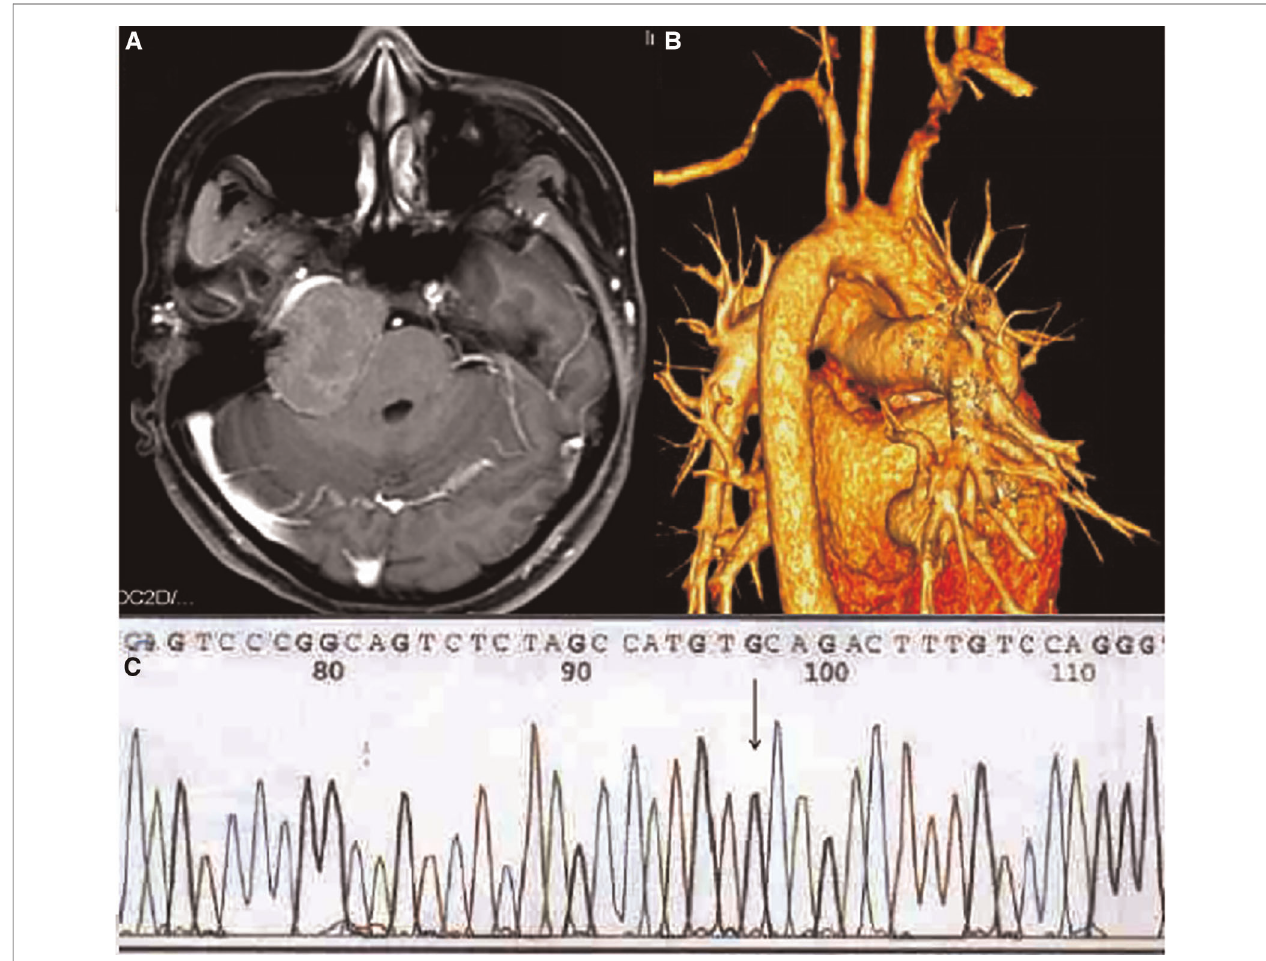
Figure 1 | ( A ) MRI showd the skull base has long T1 and long T2 lesions on the right side of the middle straddle, with fl air showing mixed signals; local bone destruction in the lesion. ( B ) Coronary CTA showed multiple mural thrombus with calci fi cation in the proximal segment of the aortic arch and the three branches of the superior arch, moderate stenosis at the origin of the left common carotid artery. ( C ) T-G mutation at position 97 in exon 6 of LDL-R gene